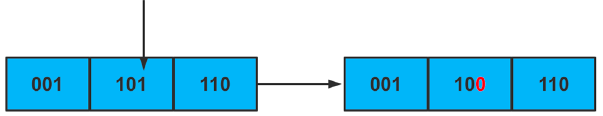
Figure 11. An alarm record before/after mutation